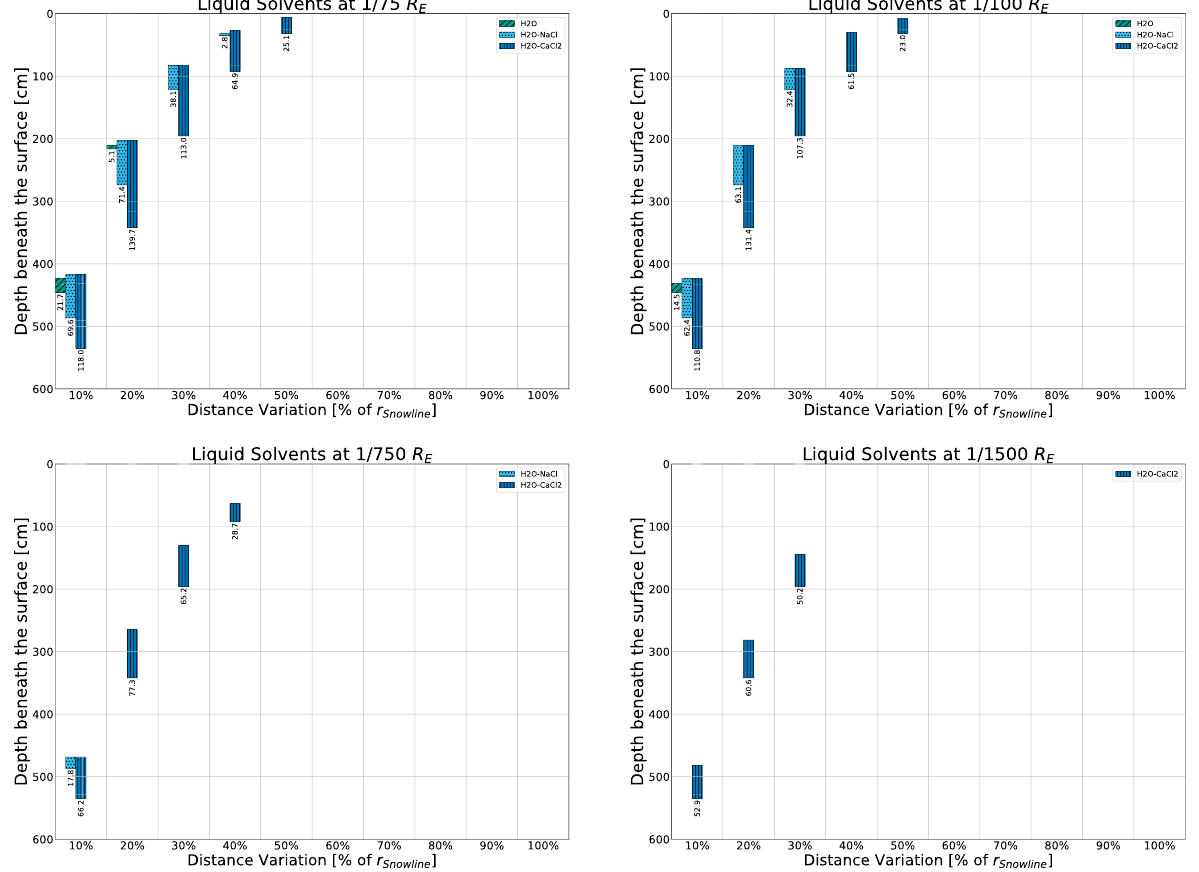
Figure A10. Liquid layers on very small bodies using the standard rocky, freshwater model ( ρ surface = 2.2765 g , ρ body = 5.51 g ). On distances close to the source, fresh water can be liquid on bodies cm 3 cm 3 R E , while both forms of saltwater can be liquid on bodies as small as 1 as small as 1 100 CaCl 2 -saltwater can be liquid even on bodies smaller than 1